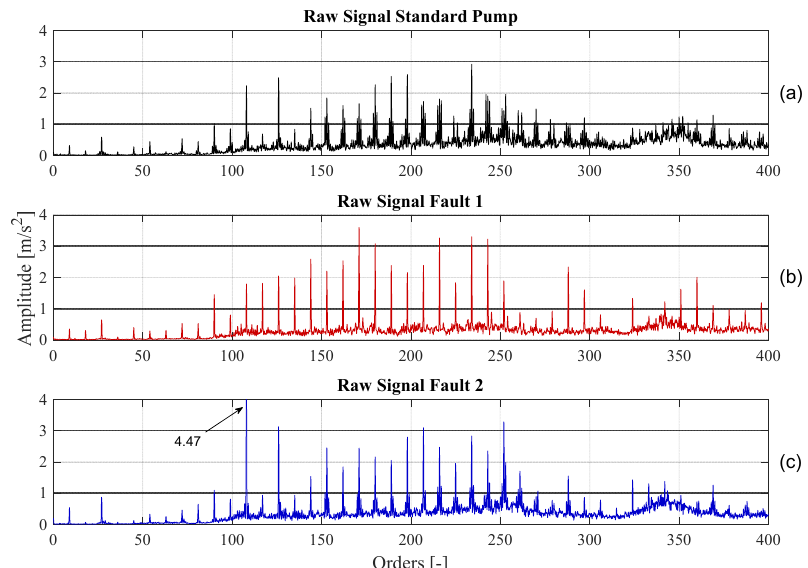
Figure 6. FFT of the raw signal for ( a ) the standard pump, ( b ) fault 1, and ( c ) fault 2 pump for the signal acquired with sensor 1 (1500 r/min, 150 bar).